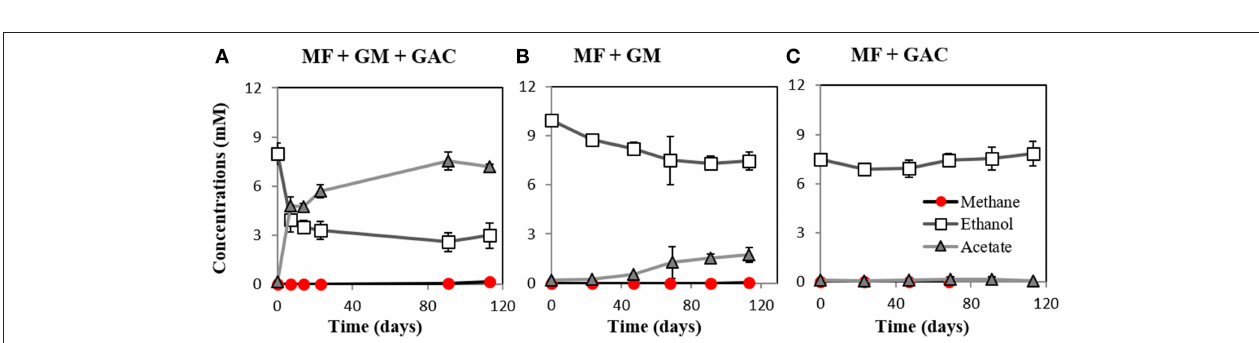
FIGURE 2 | Co-cultures experiments with M. formicicum and G. metallireducens ( n = 3). M. formicicum did not produce methane when incubated with G. metallireducens (A) in the presence of or (B) in the absence of GAC. (C) Alone, M. formicicum could not utilize ethanol or produce methane in the presence of GAC. MF, Methanobacterium formicicum ; GM, Geobacter metallireducens ; GAC, granular activated carbon.